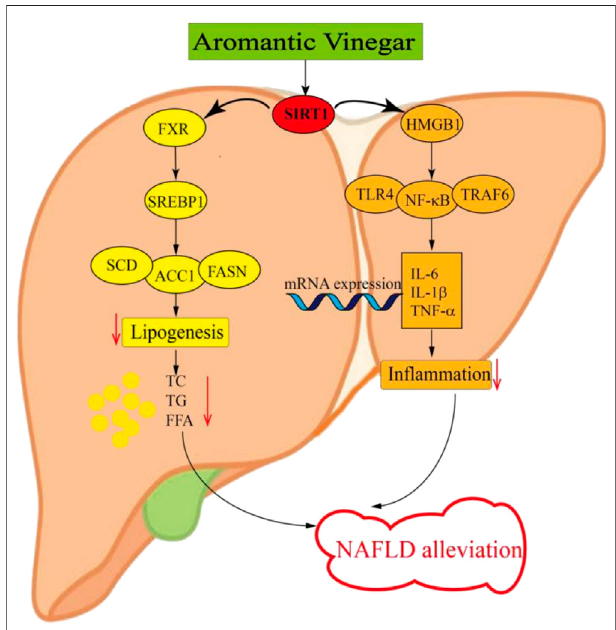
FIGURE 8 | Schematic diagram of the anti-lipid metabolism and anti- in fl ammatory effect of Hengshun aromatic vinegar.